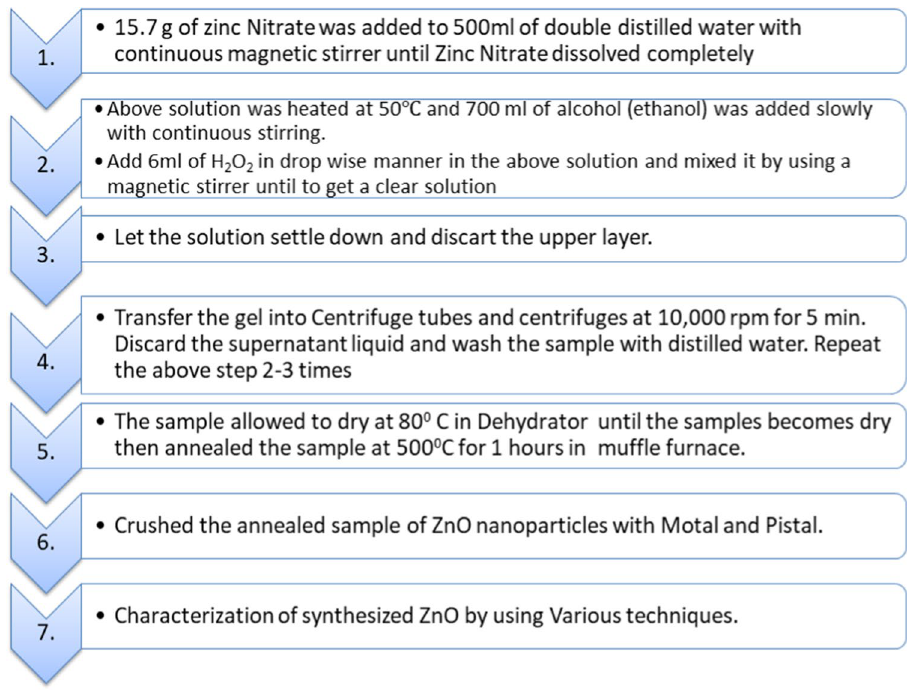
Fig. 2 Flow Diagram of syn- thesis of ZnO nanoparticles by sol- gel